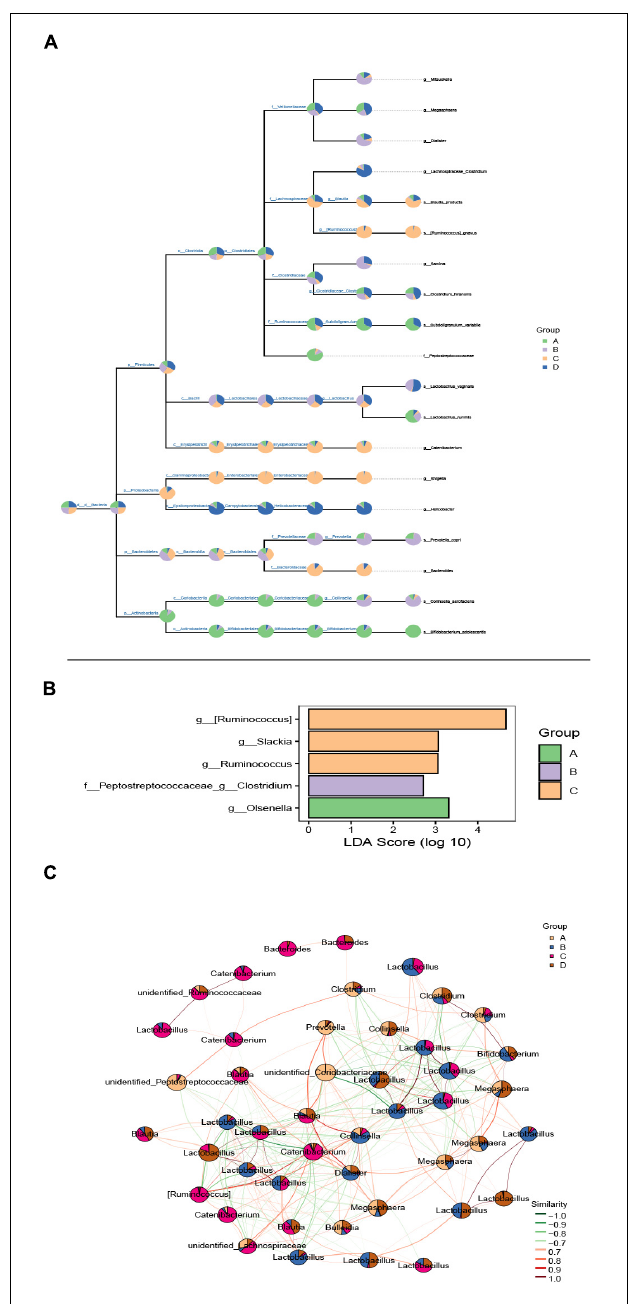
FIGURE 4 | The effect of BBr on gut microbiota composition. (A) Classification hierarchy tree diagram. The pie chart (threshold 0.5%) of each branch node in the classification hierarchy tree shows each group’s composition proportion of the taxon. The fan-shaped area represents the abundance of bacteria, and there is a positive relationship between them. (B) Histogram of marker species’ LDA affects value. The X -axis represents the logarithmic score value of LDA analysis, which is higher between groups and is more different. Y -axis is the marker species. (C) Dominant seed network diagram. The node size is proportional to its abundance [log2 (CPM/N) as a unit]. The pie chart shows the relative abundance ratio in different groups. The edge line indicates a correlation between the two nodes connected. The red line indicates a positive correlation, and the green line indicates a negative correlation. A: CON group; B: DSS group; C: L-BBr group; and D: H-BBr